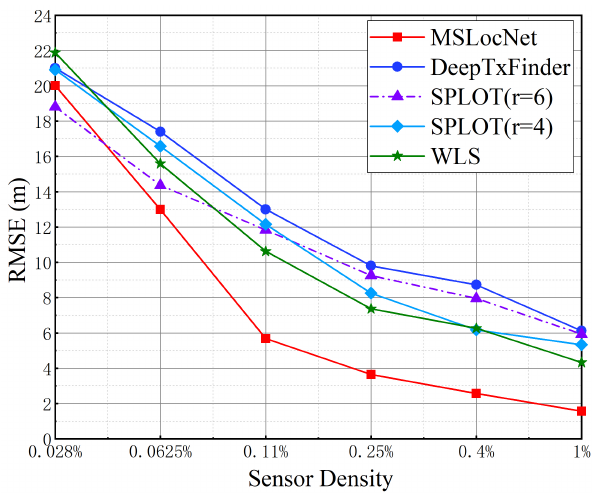
Figure 7. The RMSE for different α